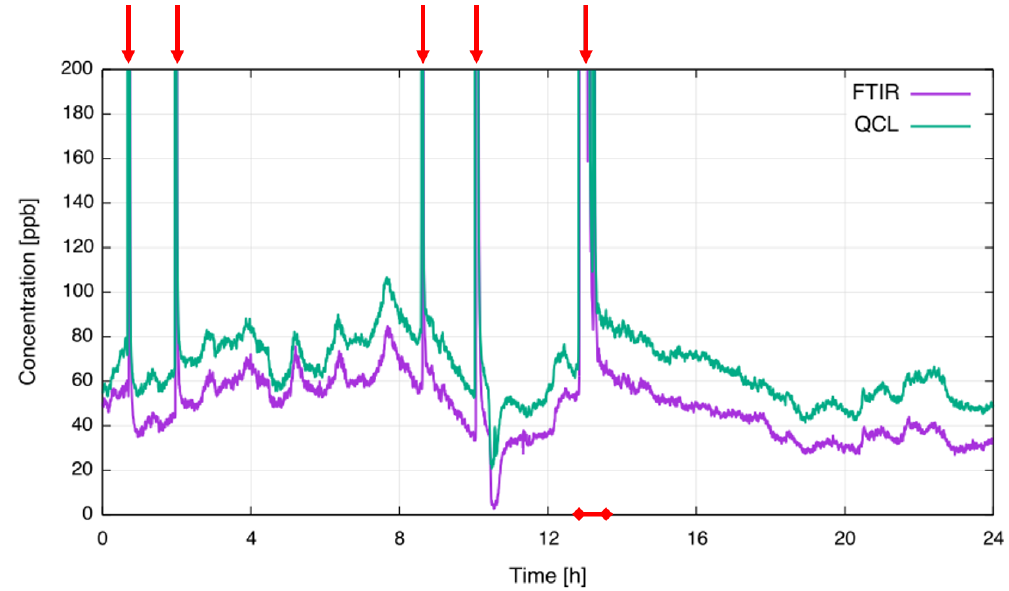
Figure 6. Comparison of extractive FTIR and in-situ QCL concentration measurements. Anode effects are indicated by red arrows. The red-marked section is plotted in Figure 7 with full